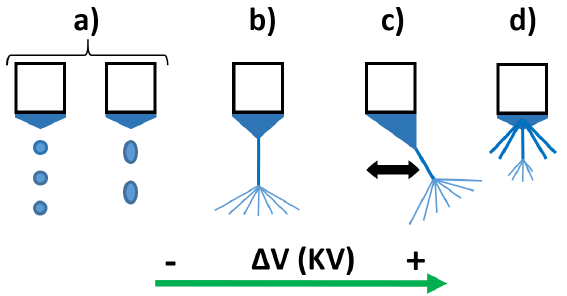
Figure 6. Schematic diagram of main electrospinning modes: ( a ) dripping mode, ( b ) cone jet mode, ( c ) oscillating mode, and ( d ) multi-jet mode.